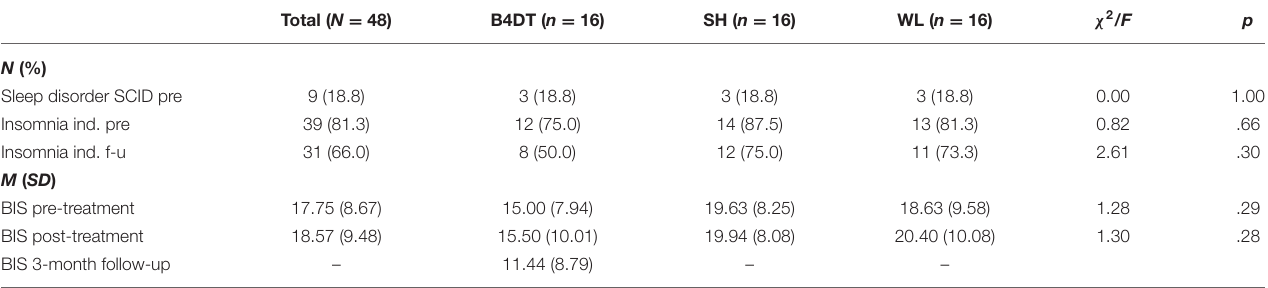
TABLE 2 | Comparisons of insomnia symptoms in the three treatment conditions.